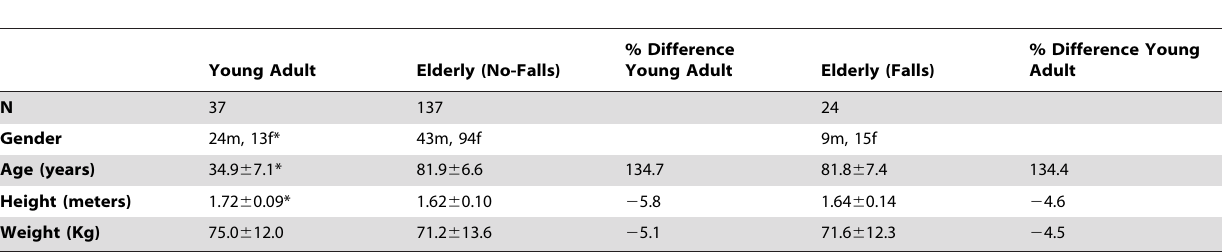
Table 1. Demographic Data of the young adult, elderly without a history of falls, and the elderly population with a self-reported incidence of falls which had occurred in the prior six months.